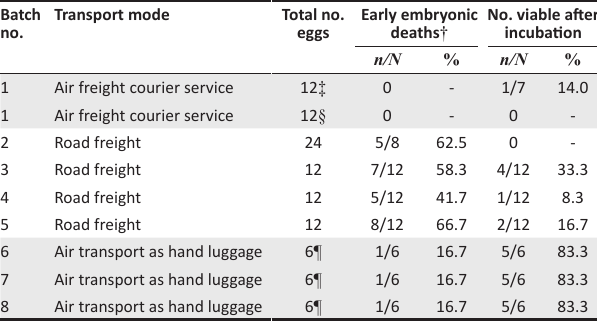
TABLE 1: Effect of mode of long-distance transport on embryonated ostrich egg viability. Batch Transport no.